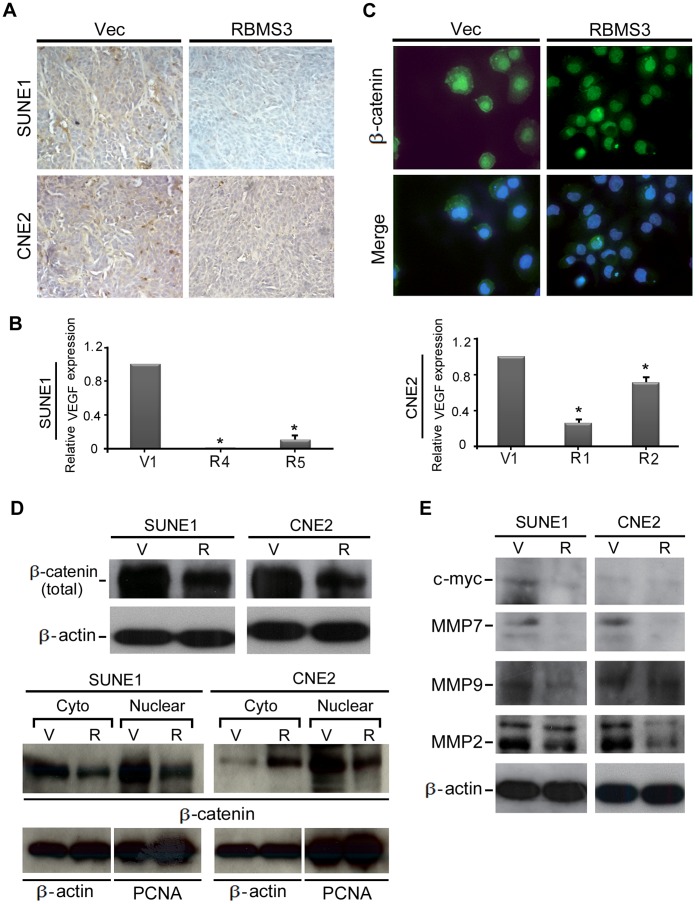

RBMS3 inhibits angiogenesis.(A) The tumor sections were stained for the endothelial cell marker CD34 (×200). The RBMS3-induced tumors had a lower degree of microvessel densities compared to empty vector-induced tumors. (B) Expression of VEGF in RBMS3-transfected SUNE1 and CNE2 cells was confirmed by qPCR. Empty vector-transfected cells were used as control. (C) Representative IF images showed that β-catenin was mainly localized in the nucleus of SUNE1-RBMS3 cells, whereas it was mainly localized in cell membrane and cytoplasm in SUNE1-V1 cells. (D) Western blot analysis of β-catenin from whole cell, nuclear and cytosolic extract was compared between in RBMS3- and empty vector-transfected SUNE1 and CNE2 cells. β-actin and PCNA were used as loading control. (E)Western blot analysis of c-Myc, MMP7, MMP9 and MMP2 was compared between RBMS3- and empty vector-transfected SUNE1 and CNE2 cells. β-actin was used as loading control.